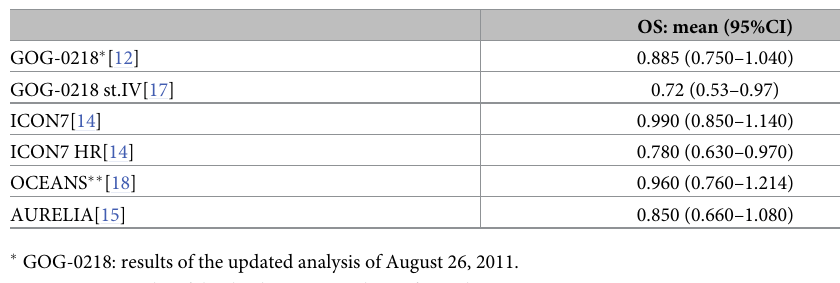
Table 2. OS hazard